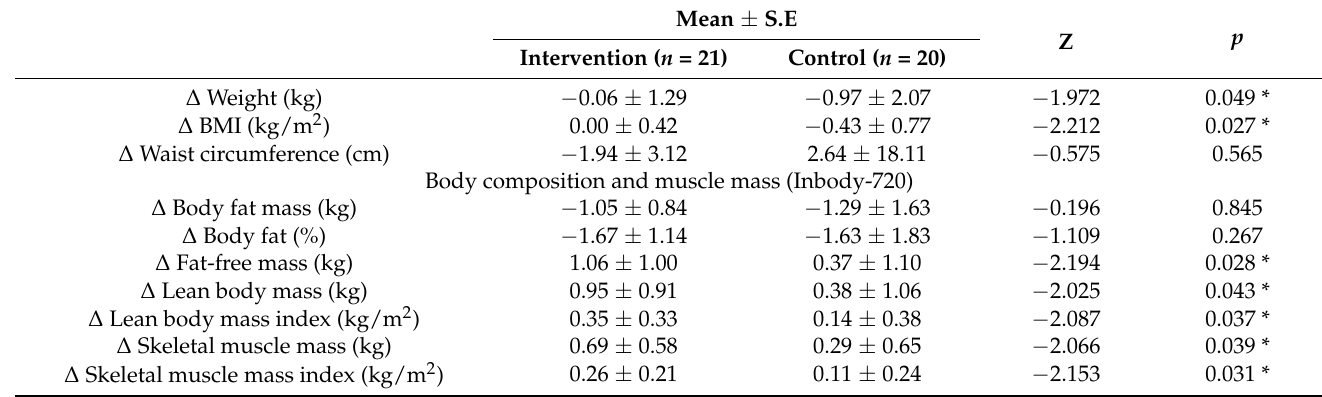
Table 8. Comparison of changes in 12 weeks in the control group and intervention